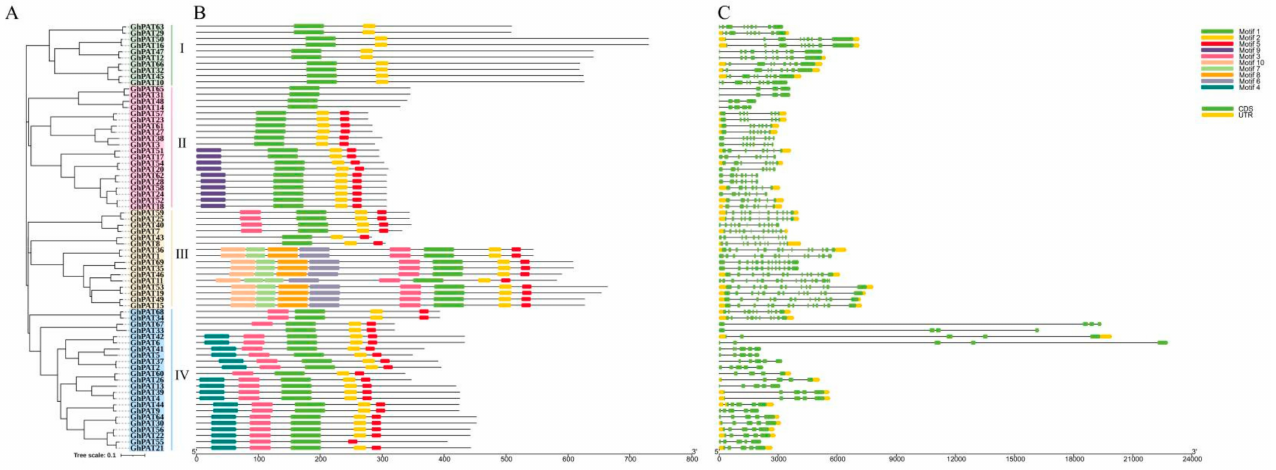
Figure 3. Gene structural analysis and motif prediction of GhPATs proteins ( A ) GhPATs phylogenetic tree; ( B ) GhPATs motif prediction; ( C ) GhPATs inline-exon structure